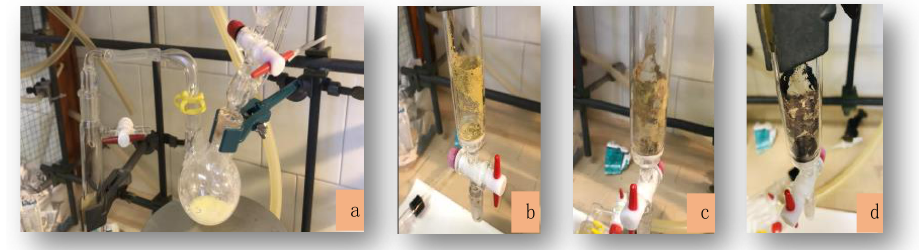
Figure 1. Pictures of the synthesis of MnL 2 under inert conditions: ( a ) the yellow precipitate that forms under inert atmosphere; ( b ) the yellow precipitate after filtration and washing under inert atmosphere; ( c ) color darkening when it comes into contact with air; ( d ) brown product after 60 min contact with air.